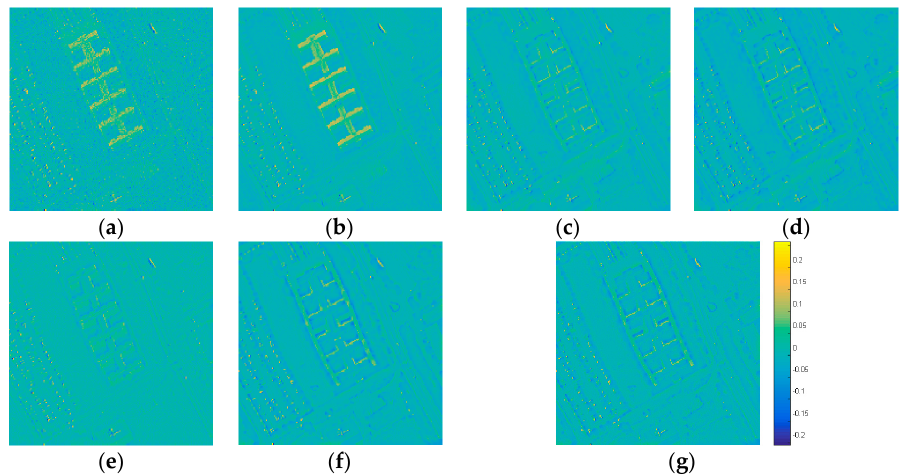
Figure 8. Visual comparison of difference image (light blue means small differences) between each fused HS image and the reference HS image (Paiva University dataset). ( a ) PCA; ( b ) GFPCA; ( c ) HySure; ( d ) MGH; ( e ) CNMF; ( f ) Sparse Representation; ( g ) Proposed.